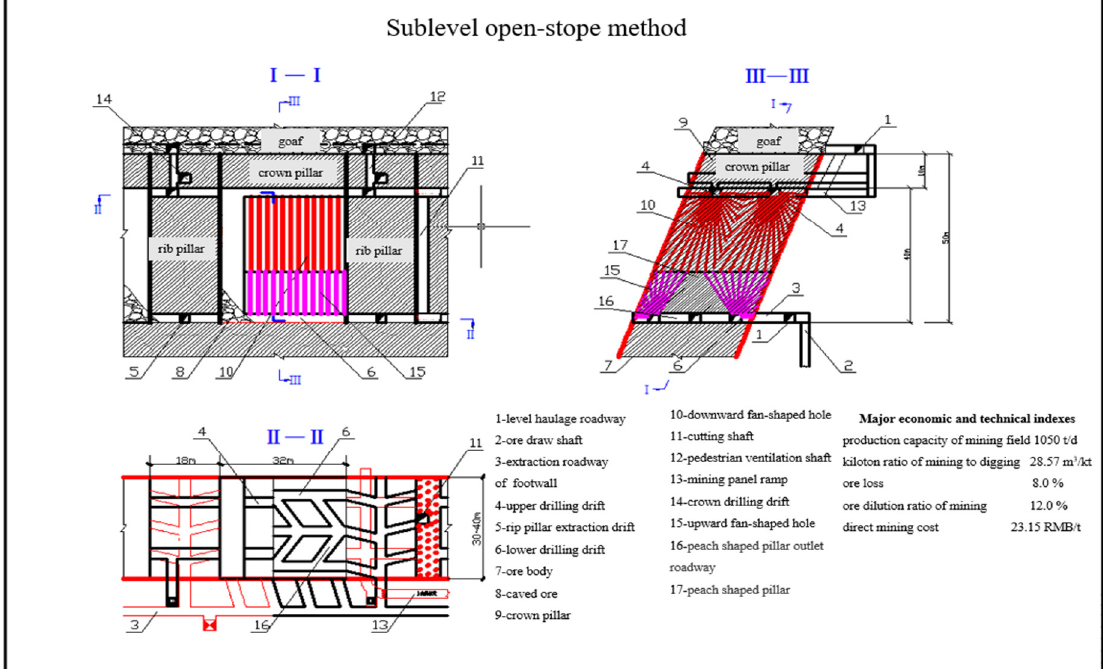
Figure 1. Schematic of mining method used in the 855 middle sublevel of the pit. (Done by the authors). At present, the 855 m middle sublevel 1# ore body goaf has been governed, and part of the goaf in the 905 m middle sublevel is backfilled with 1:10 graded tailings (height of approximately 20 m), as shown in Figure 2. To reduce ore loss and extract additional